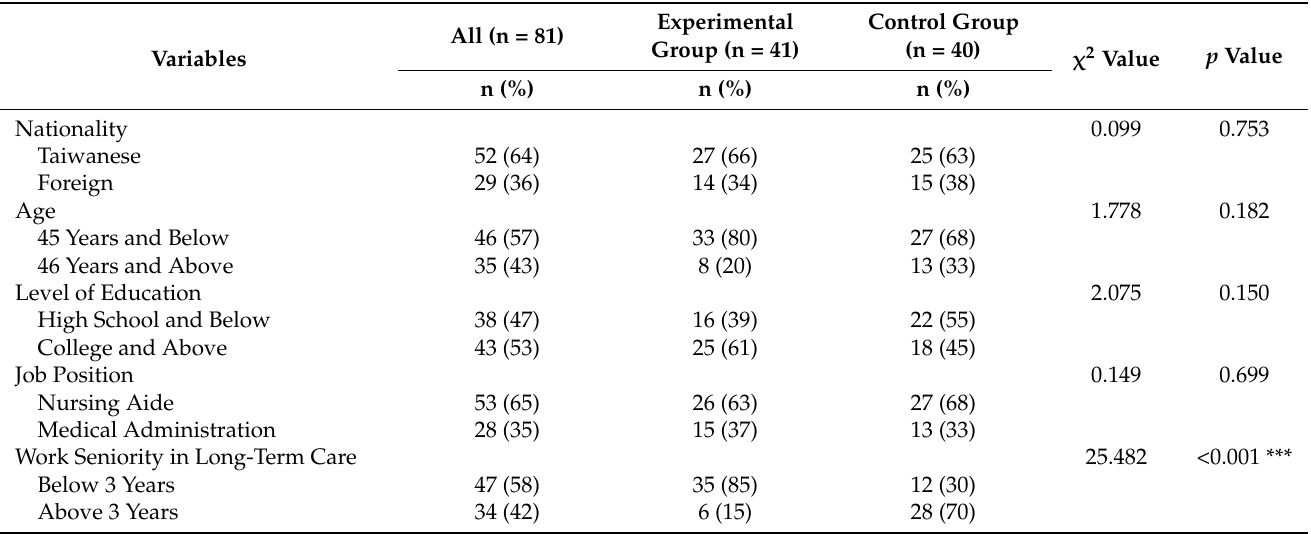
Table 1. Participants’ basic profile distribution and difference comparison (n =